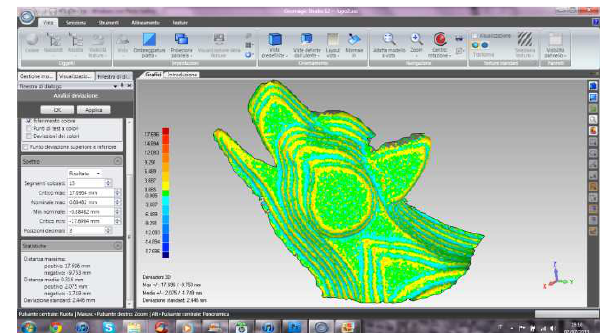
Figure 19. The deviations points-model (from the C10 scans) for the head of the Wolf of Sila Figures 15 and 16 show the point cloud obtained by C10 scans; figure 17 is a view of the relevant